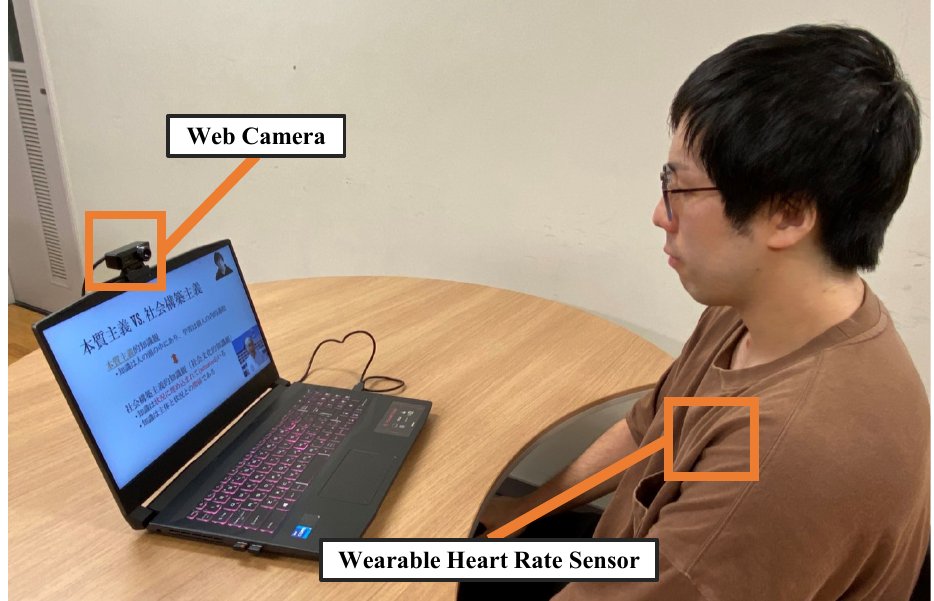
Figure 3. The participants’